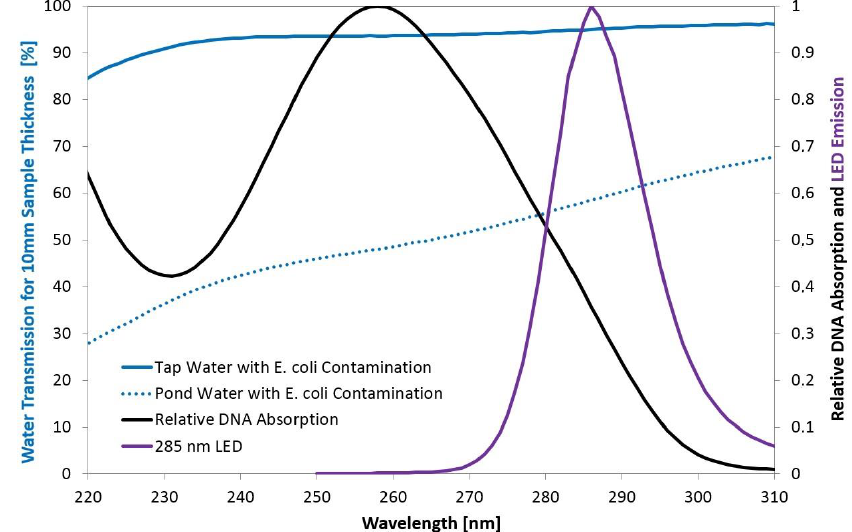
Figure 2. Transmission spectra of the different water samples for 10 mm sample thickness, together with the relative DNA absorption for E. coli calculated with [24] and the emission spectrum of the Nikkiso 285 nm LED. (The arrows indicate the corresponding axis.)